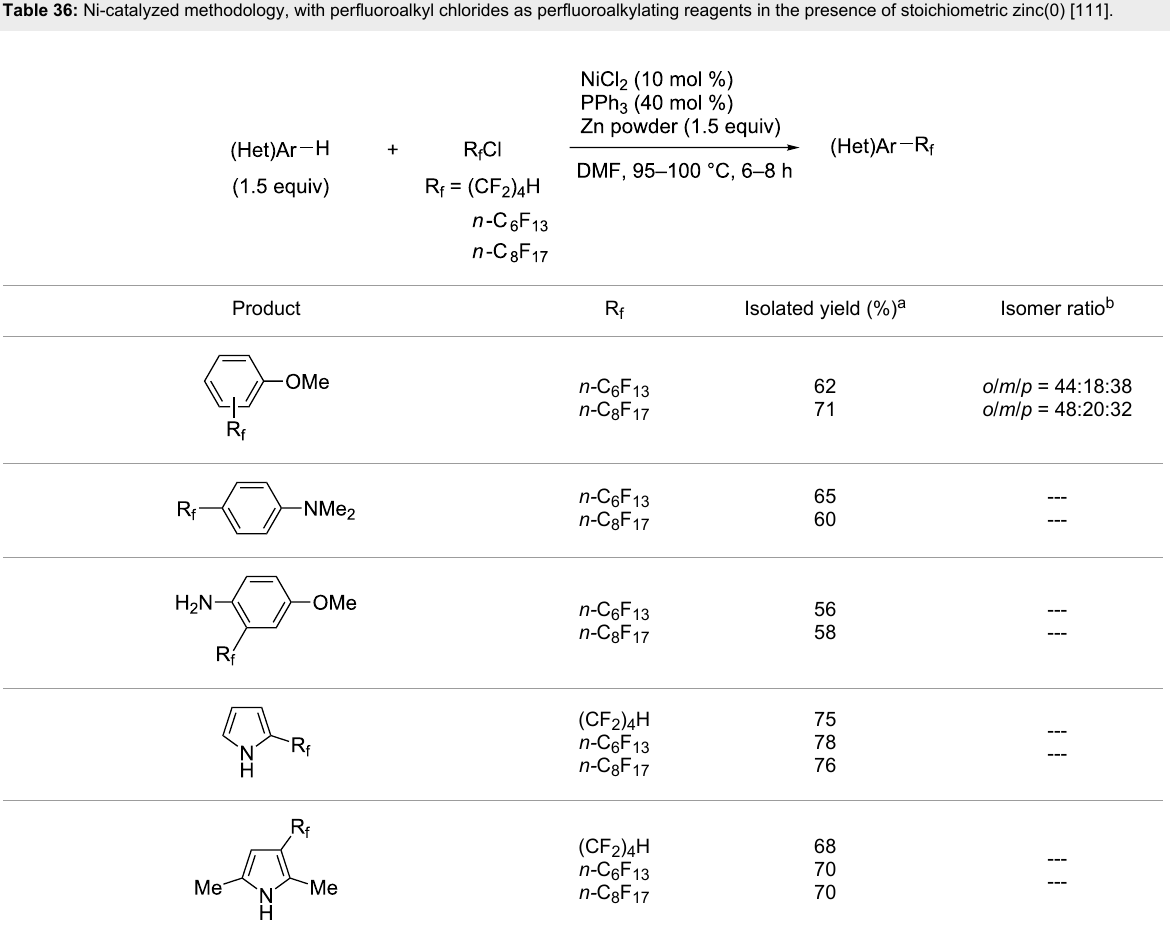
Table 36: Ni-catalyzed methodology, with perfluoroalkyl chlorides as perfluoroalkylating reagents in the presence of stoichiometric zinc(0)